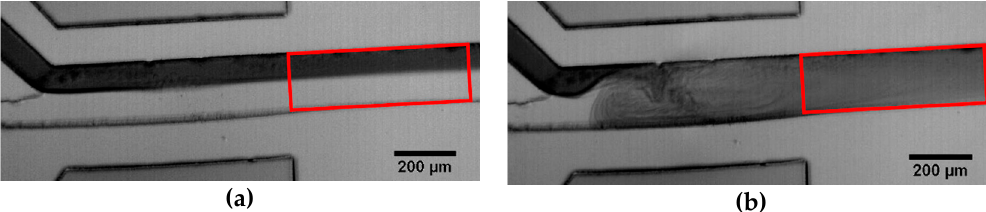
Figure 1. Typical micrographs of the mixing process. The Inter-Digital Transducers (IDT) is located above the channel outside of the micrograph: ( a ) Laminar flow without any applied surface acoustic waves (SAW); ( b ) Snapshot of the channel while mixing with SAW. The red box indicates the region which was analyzed with ImageJ.